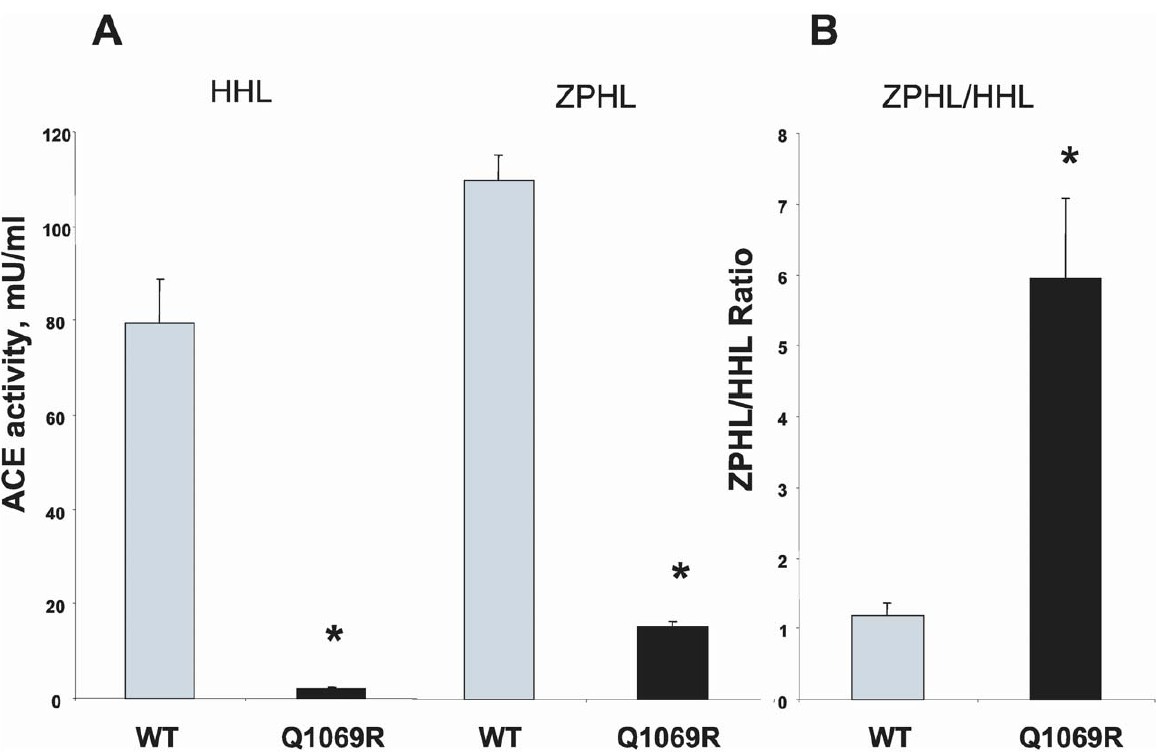
Figure 5. ACE activity of mutant ACE. ACE activity of the membrane-bound form of ACE in lysates of CHO cells expressing WT and mutant ACE was determined by fluorimetric assay of 40 m l aliquotes of cells with 200 m l each of substrates Hip-His-Leu (HHL) and Z-Phe-His-Leu (ZPHL) during 1 hr incubation. A. ACE activity with HHL and ZPHL (mU/ml), correspondingly, from a representative experiment performed in triplicate. B. Ratio of hydrolysis of the two substrates (ZPHL/HHL ratio) in the tested samples. The data are presented as mean ( 6 SD) from three independent